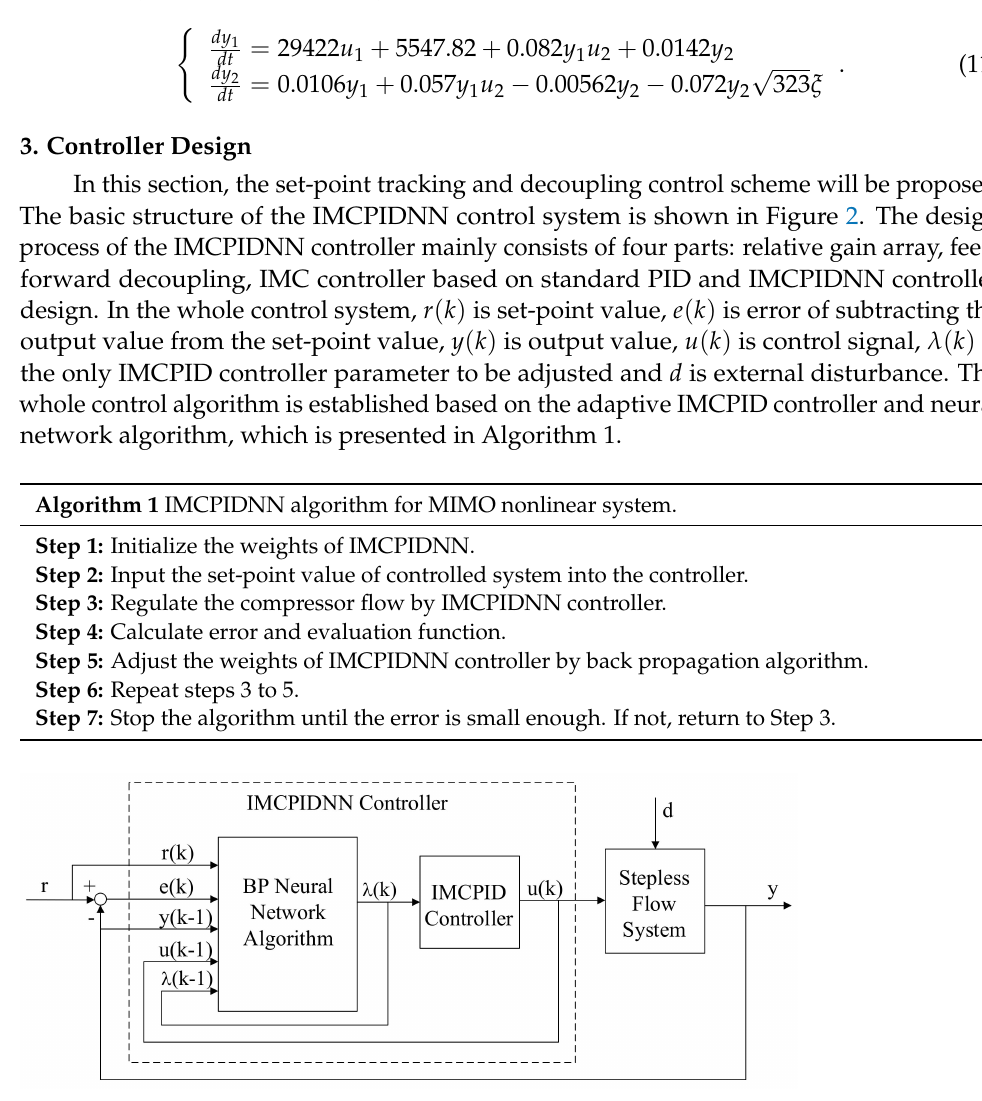
Figure 2. The block diagram of the IMCPIDNN control